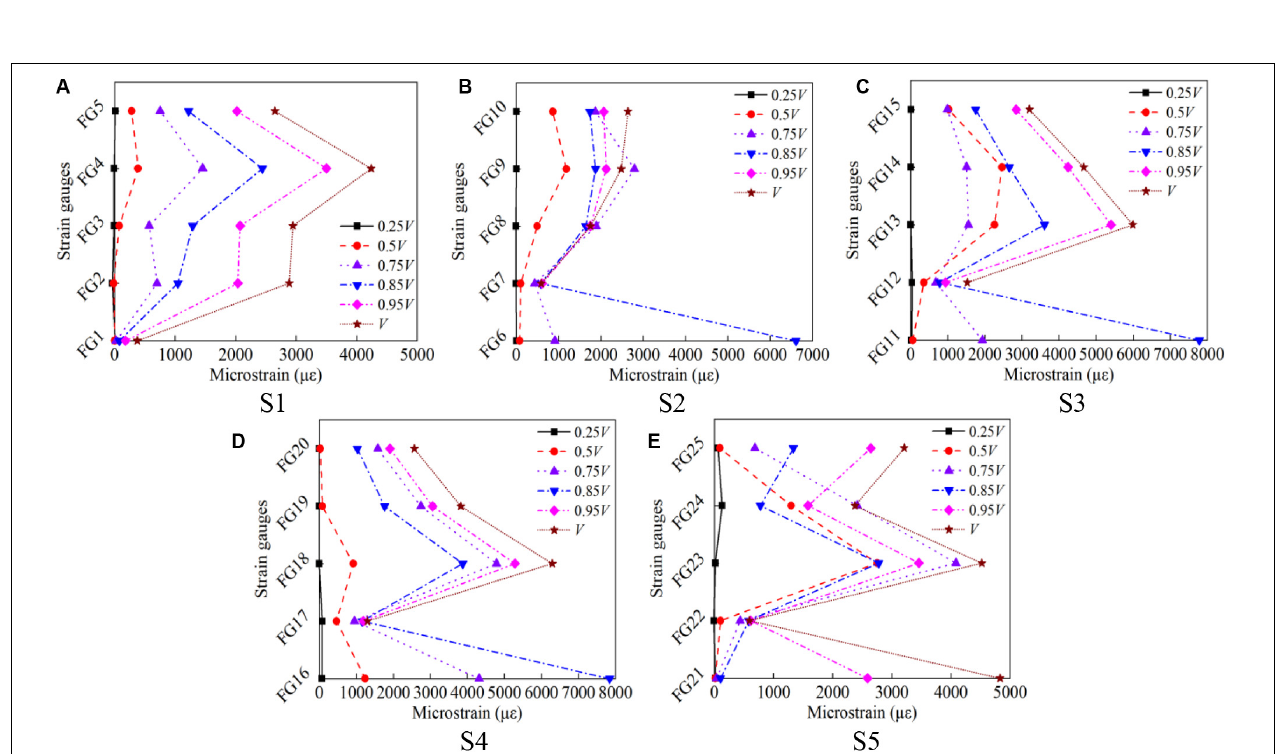
FIGURE 15 | Strain distribution along the height of CFRP strips for EA-4-5. (A) S1, (B) S2, (C) S3, (D) S4, and (E) S5.